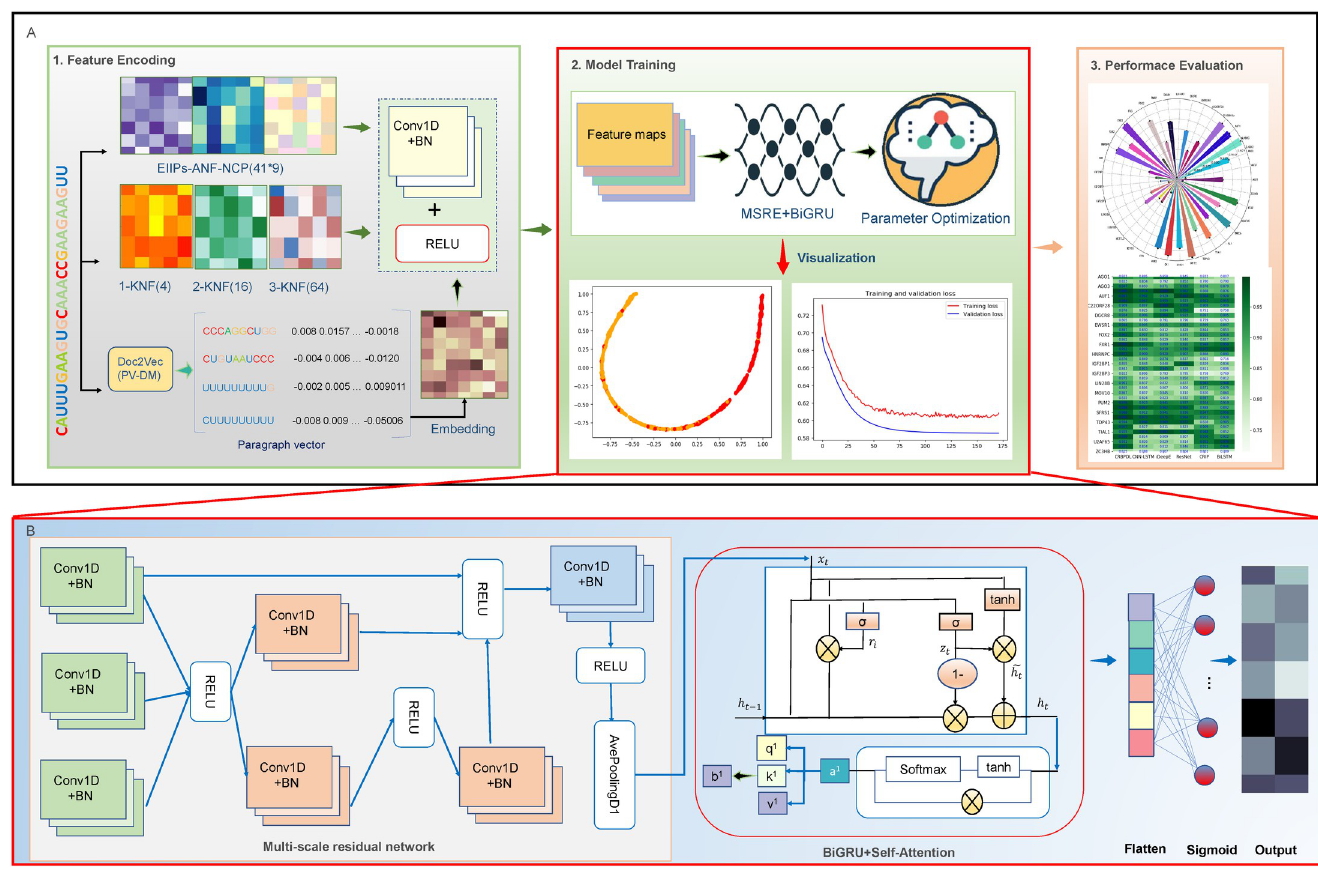
Fig 1. The overall framework of CRBPDL. (A) The workflow of the development and assessment process of CRBPDL. (B) The structure of the sig-CRBPDL framework, including the input layer, convolutional layers, merger layers, inception module, attention layers, fully connected layers and output